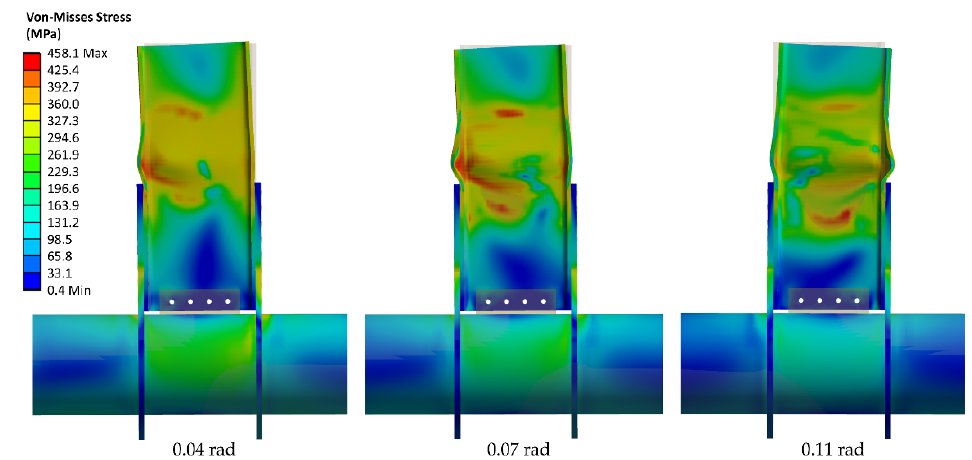
Figure 15. Results obtained for the plasticization mechanism of the numerical model after the second simplification.